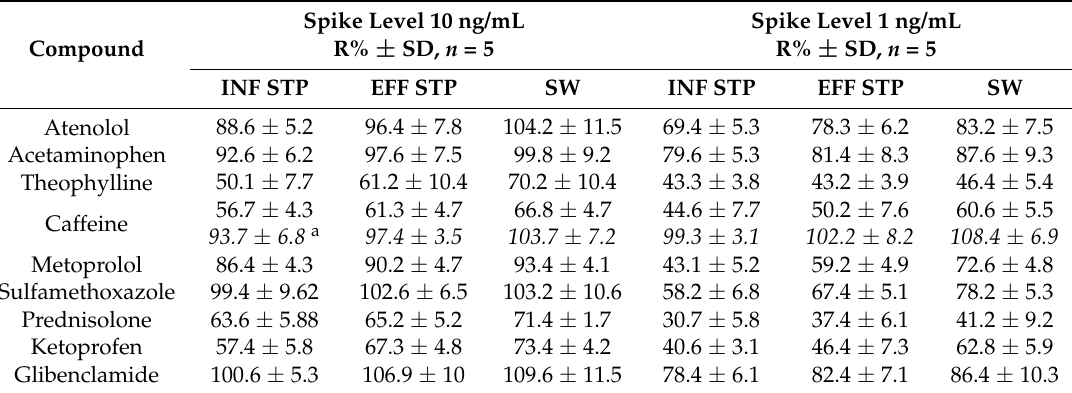
Table 5. Recovery for all studied pharmaceuticals at different spike levels 1 and 10